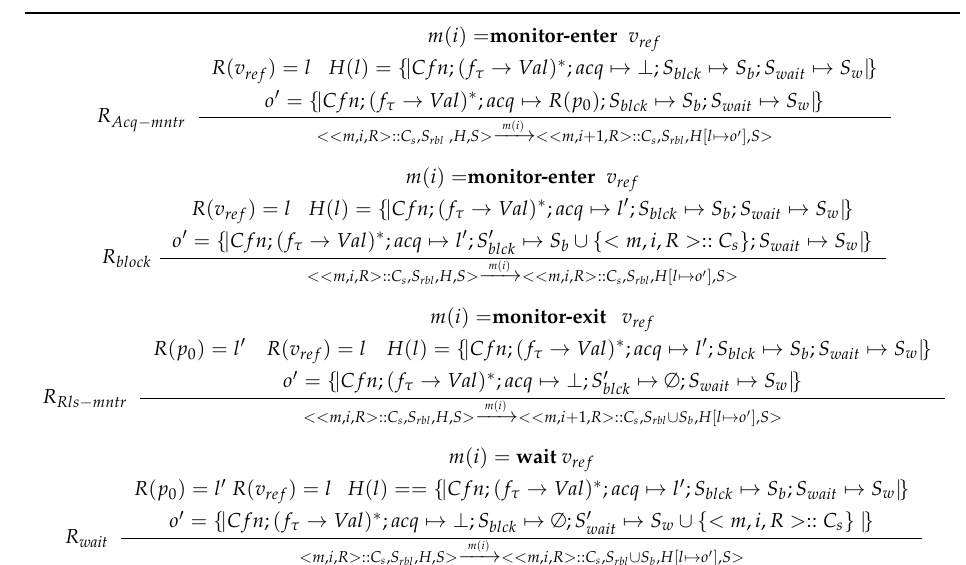
Table 9. Multi-threaded semantics: